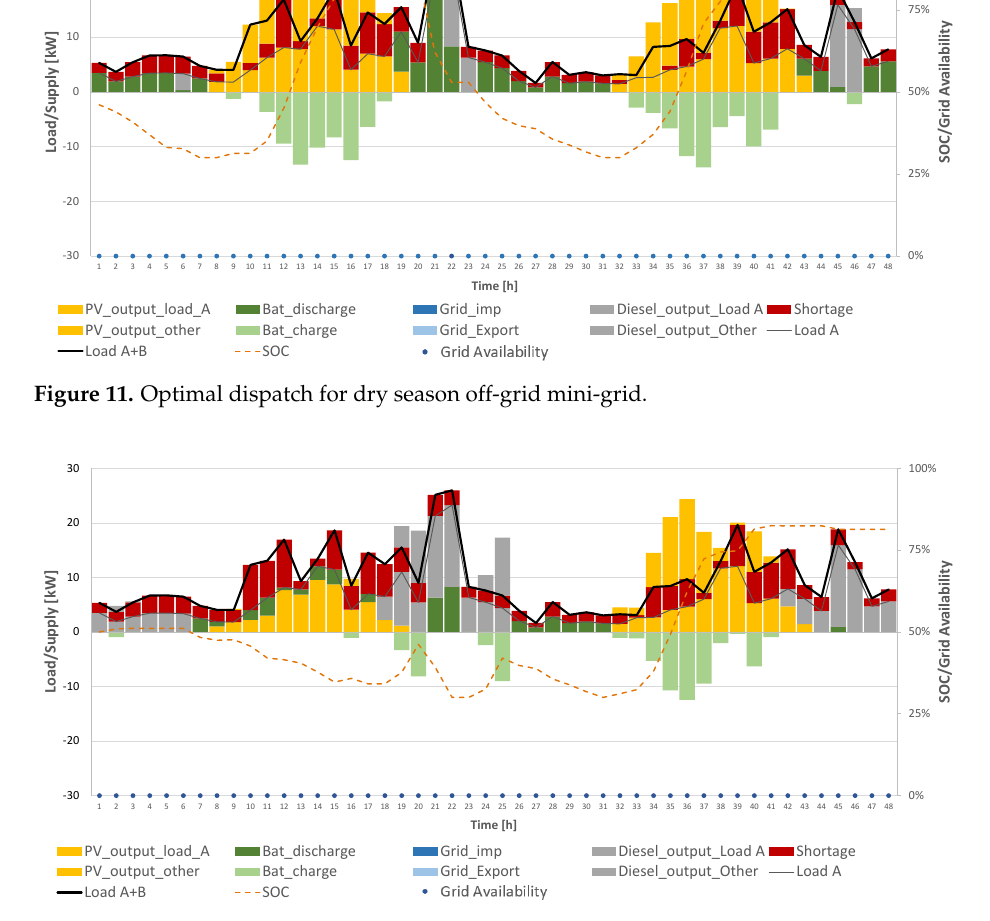
Figure 12. Optimal dispatch for rainy season off-grid